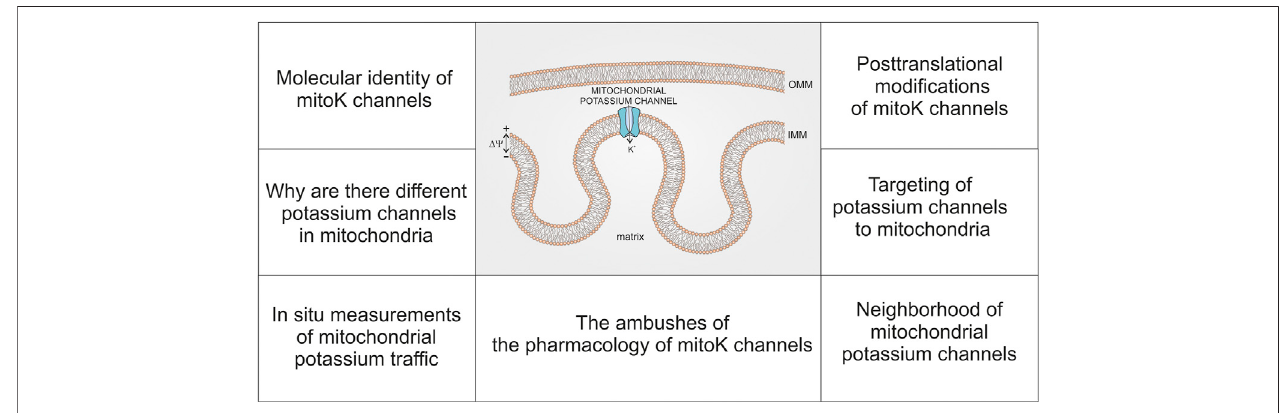
FIGURE 1 | Schematic presentation of topics related to the current state of research on mitochondrial potassium (mitoK) channels — discussed in this